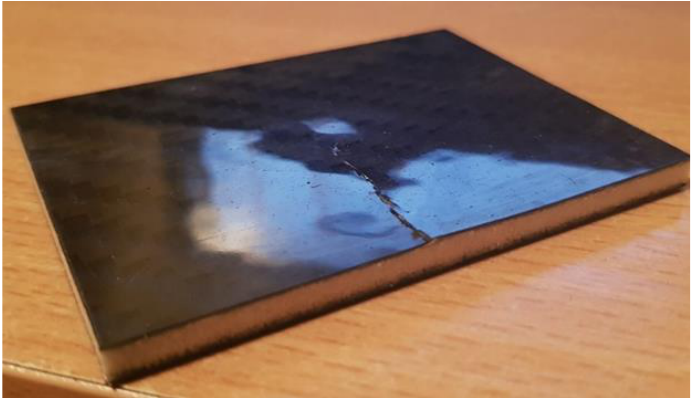
Figure 9. Herex 75 core composite with a crack at the side of energy application equal to 5 J. Already at an energy of 5 J, minor damage to the second face was observed in the Herex 55 composite with the smallest thickness (Figure 10).